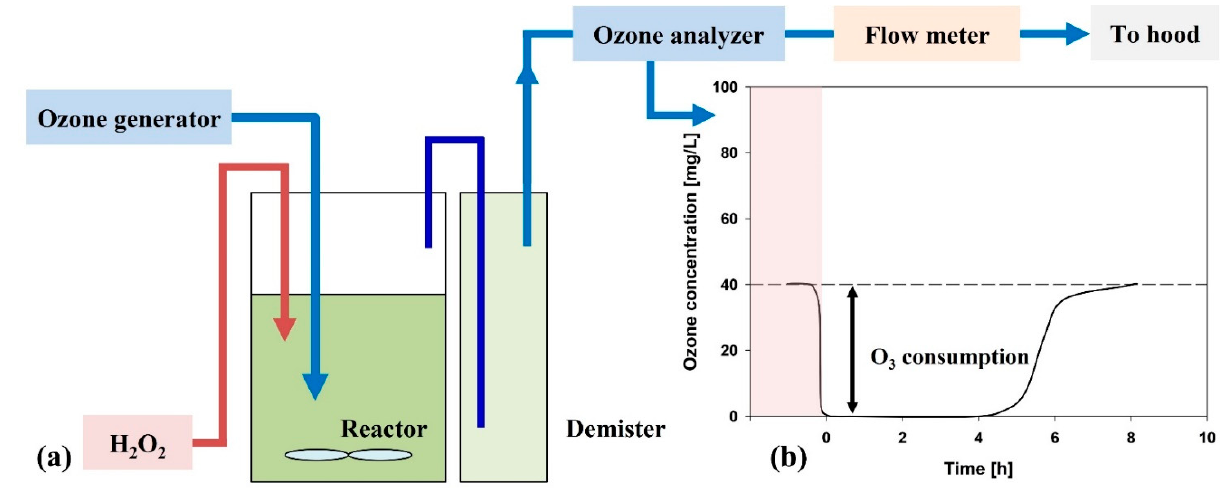
Figure 1. Schematic diagram of the ozone and peroxone oxidation experiments: ( a ) oxidation equipment; ( b ) ozone concentration of effluent gases during the reaction; H 2 O 2 injection was made only in the peroxone experiment.